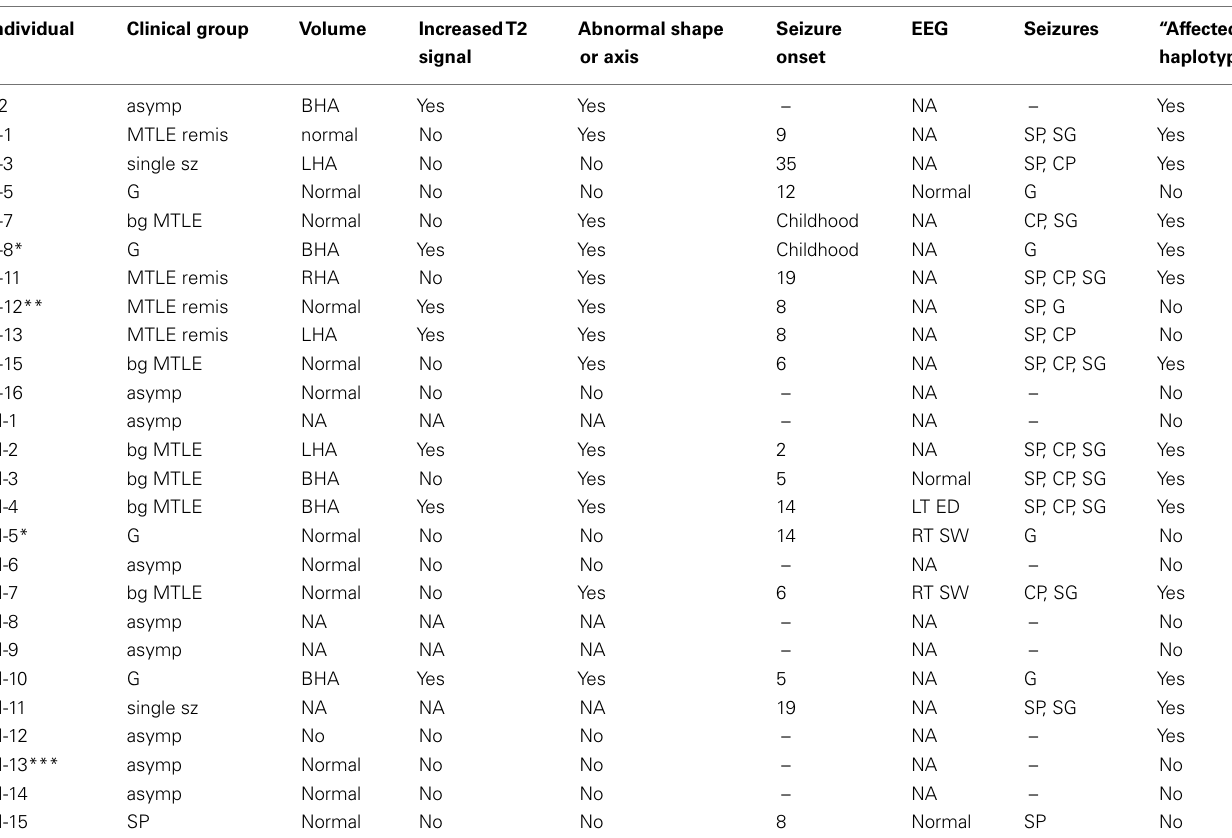
Table 2 | Clinical information for family